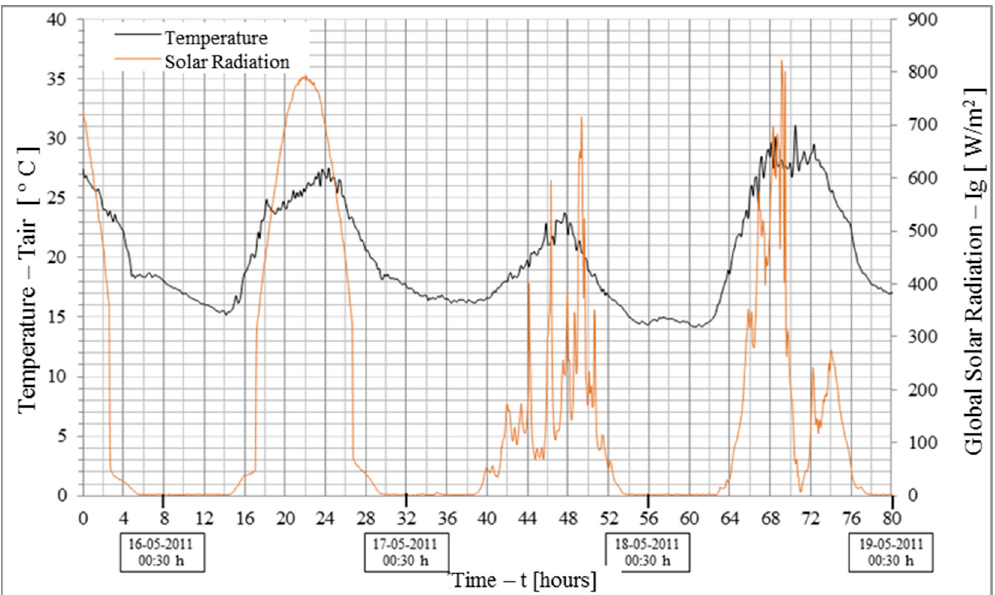
Figure 5. Monitoring of exterior temperature (T air ) and solar radiation (I g ) between 15 and 19 May 2011.